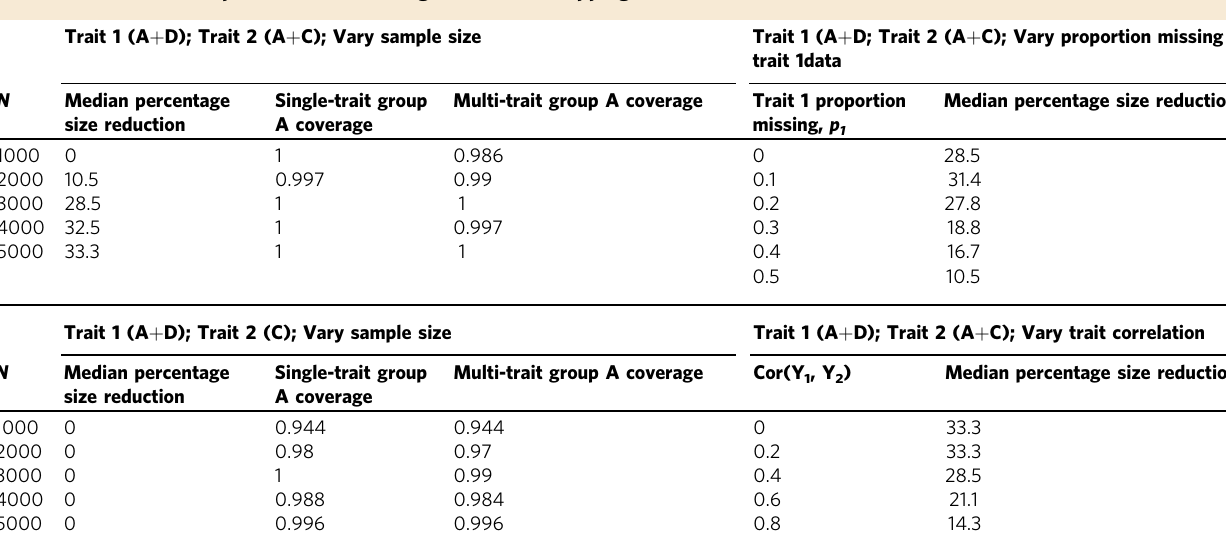
Table 1 Resolution comparison between single-trait fi ne-mapping and fl ashfm. Trait 1 (A + D); Trait 2 (A + C); Vary sample size Trait 1 (A + D; Trait 2 (A + C); Vary proportion missing